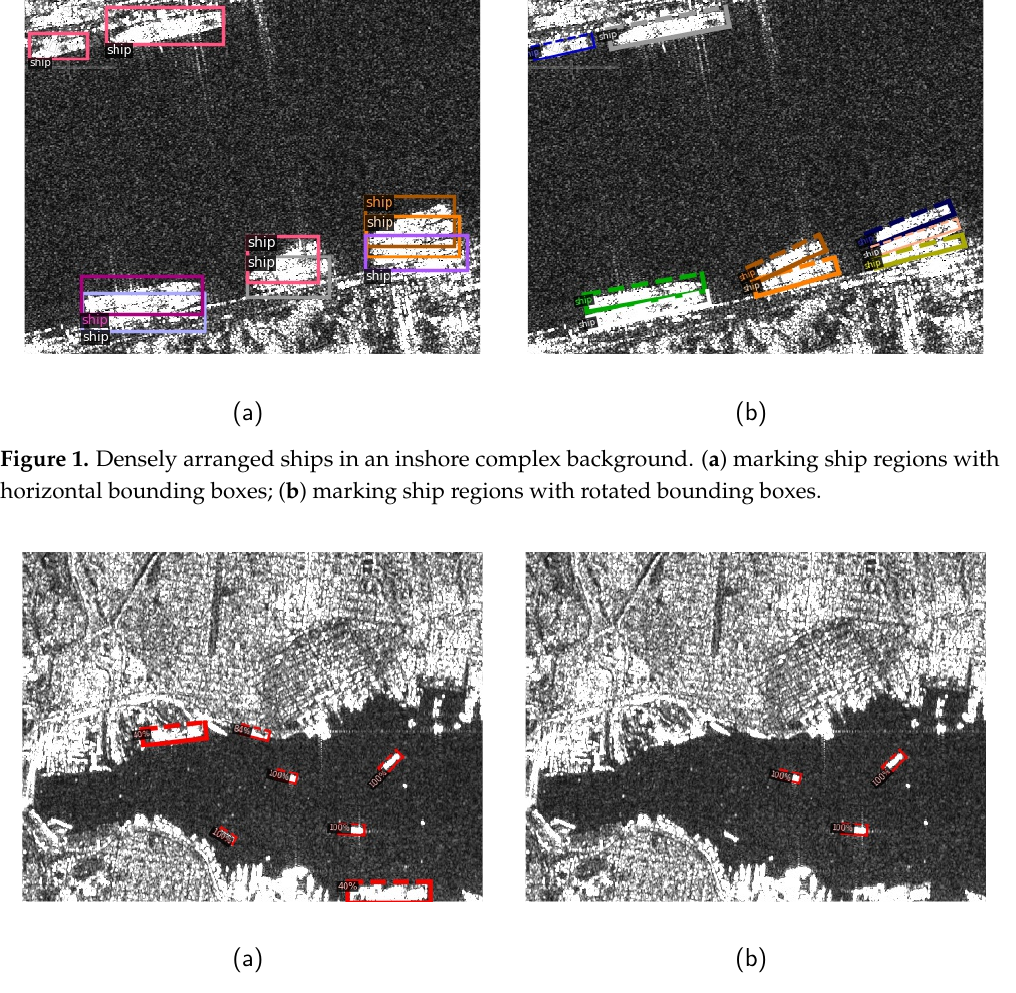
Figure 2. Detection results under different IoU thresholds; ( a ) detection results under a IoU threshold of 0.5; ( b ) detection results under a IoU threshold of